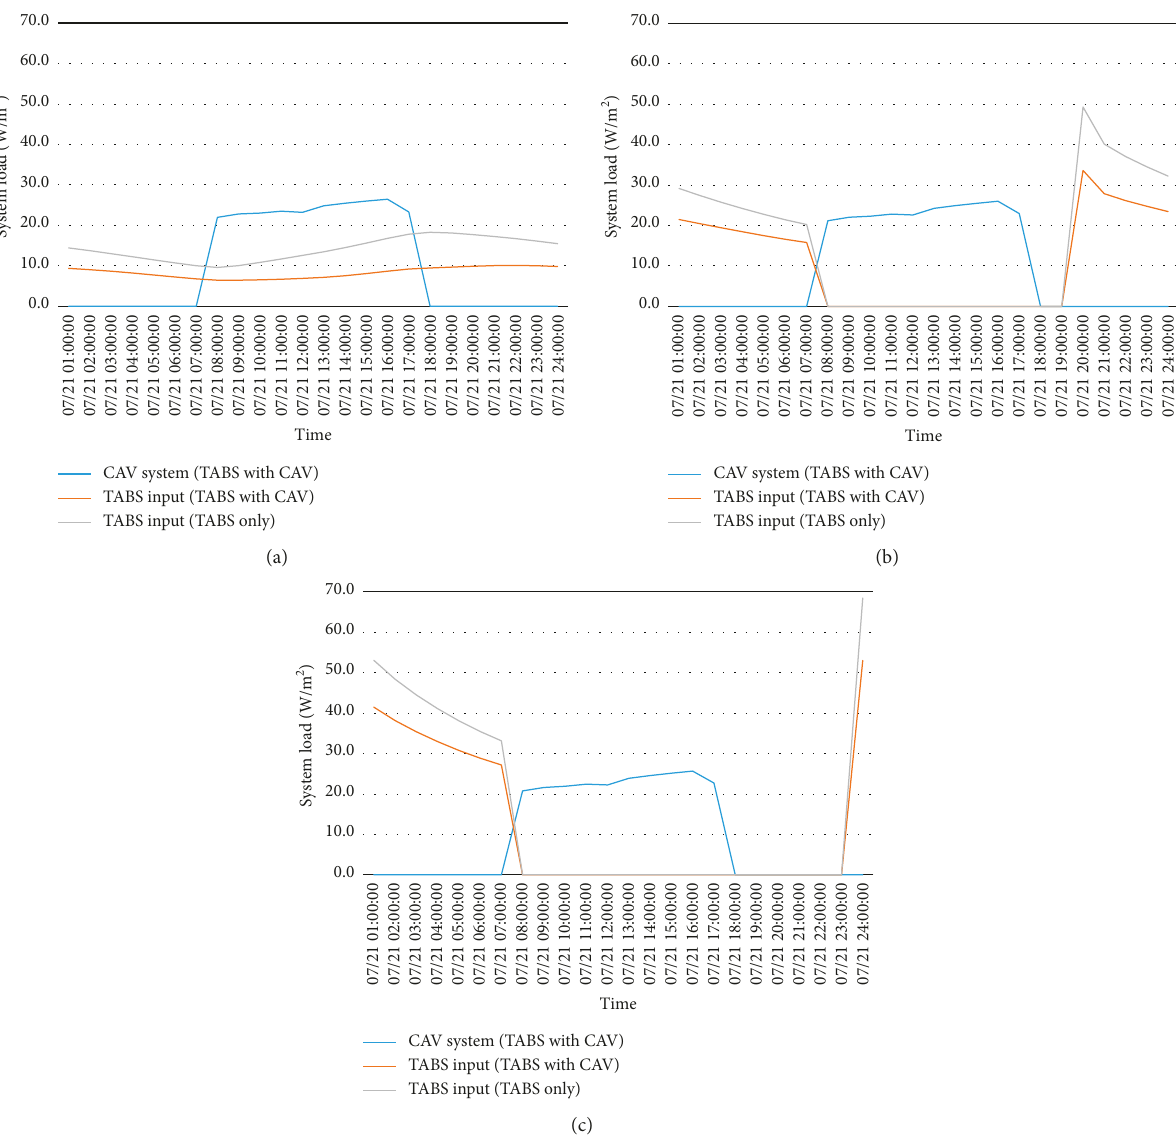
CAV system (TABS with CAV) TABS input (TABS with CAV)